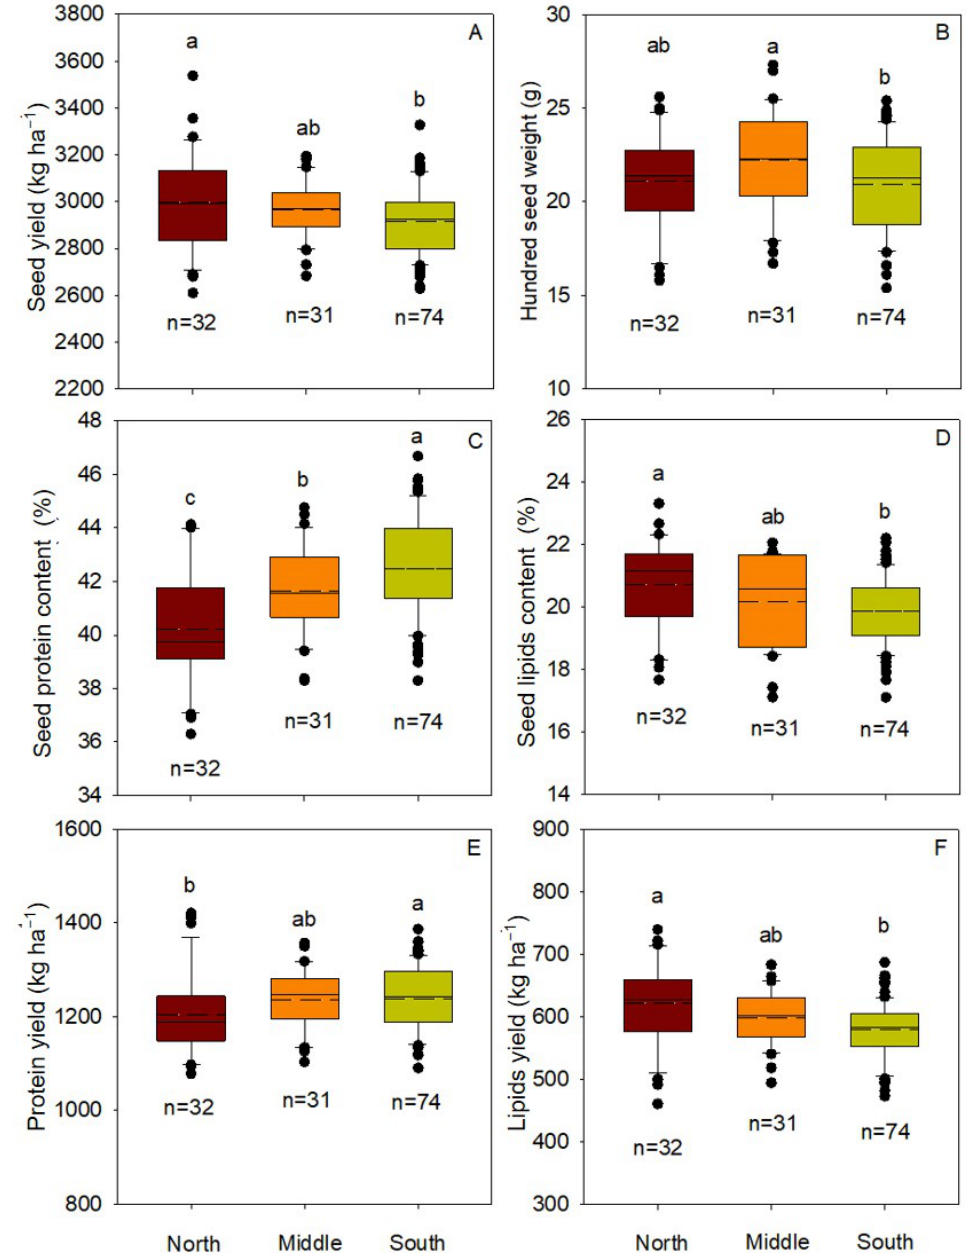
Figure 2. The framework of the proposed method. Figure 2. Seed yield ( A ), hundred seed weight ( B ), seed protein content ( C ), seed lipids content ( D ), protein yield ( E ), and lipids yield ( F ) of soybean across the Huang-Huai-Hai region of China. The same lowercase letters for the different regions indicate that the differences are not statistically significant at p < 0.05. The solid and dashed lines within the boxes indicate medians and means, respectively; the upper and lower edges of the box represent the 25th and 75th percentiles of all the data, and the bottom and top bars represent the 5th and 95th percentiles, respectively. Solid black circles are